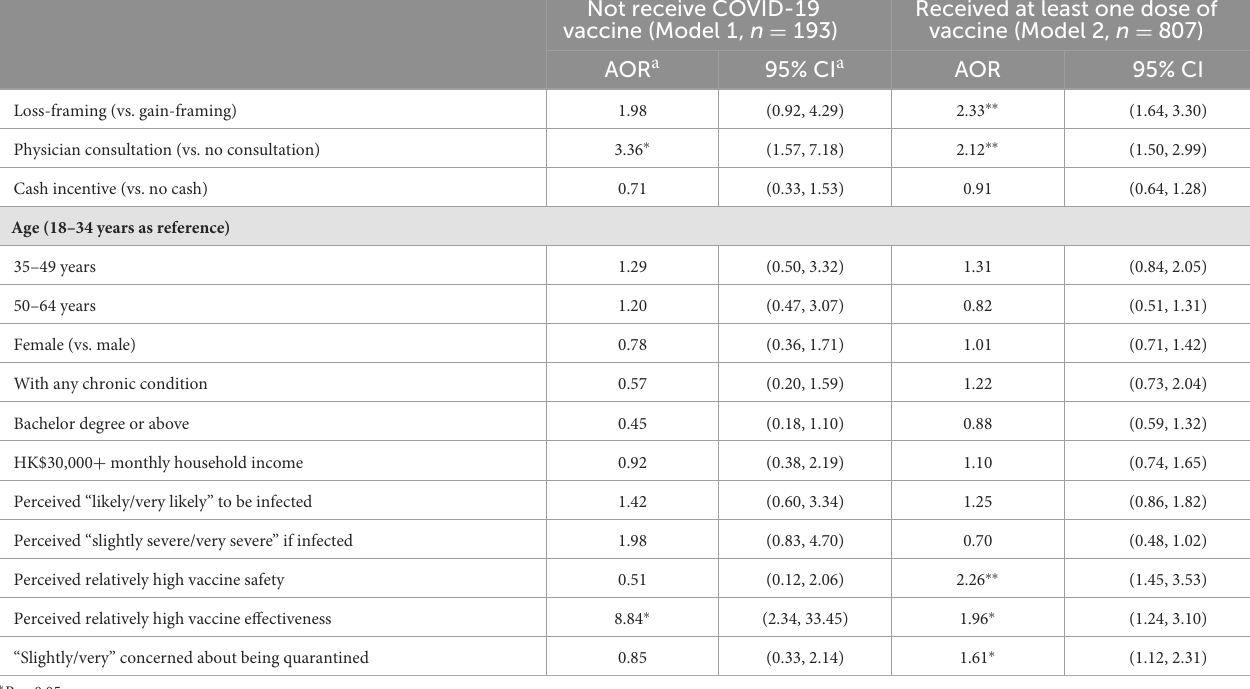
TABLE 2 Association between vaccine acceptance and the three strategies with adjustment of socio-demographic factors and psychosocial perceptions.